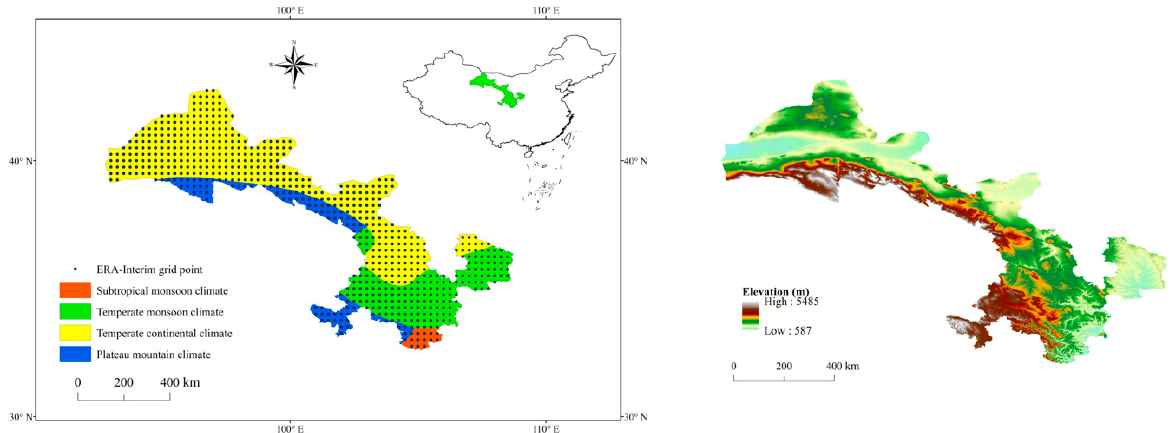
Figure 1. Distribution of ERA-Interim grid points across four climate zones ( left ) and elevation information ( right ) of Gansu Province.